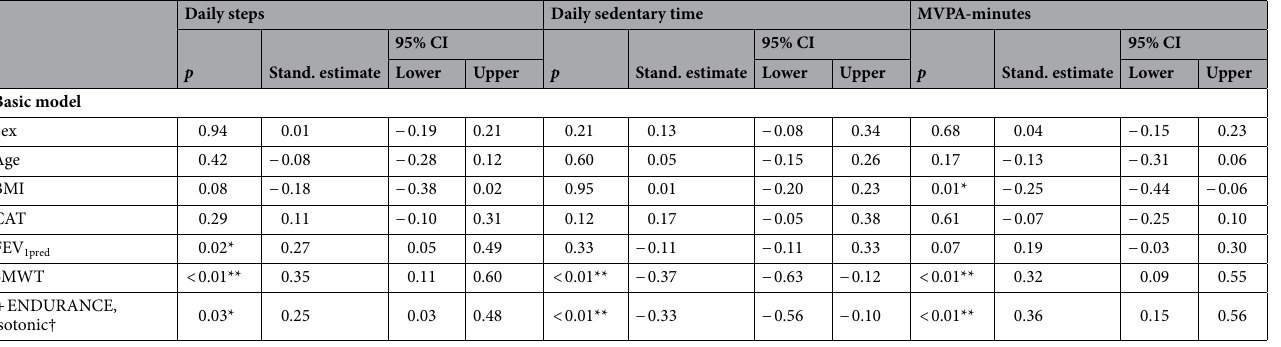
Table 4. Standardized estimates of the multiple linear regression models with the best coefficient of determination for sedentary time, daily steps, and MVPA-minutes. Models with a measure of quadriceps endurance are shown when there was a significant change in the coefficient of determination from the basic model including; gender, age in years, BMI, CAT, FEV1pred and 6MWT. MVPA time spent in moderate to very vigorous intensity, BMI body mass index, CAT COPD assessment test, higher values indicating more symptoms, FEV1pred forced expiratory volume in the first second in percent of predicted, 6MWT 6-minute walk test. * p < .05, ** p < .01, *** p < .001, † the best quadriceps function from the multiple linear regression